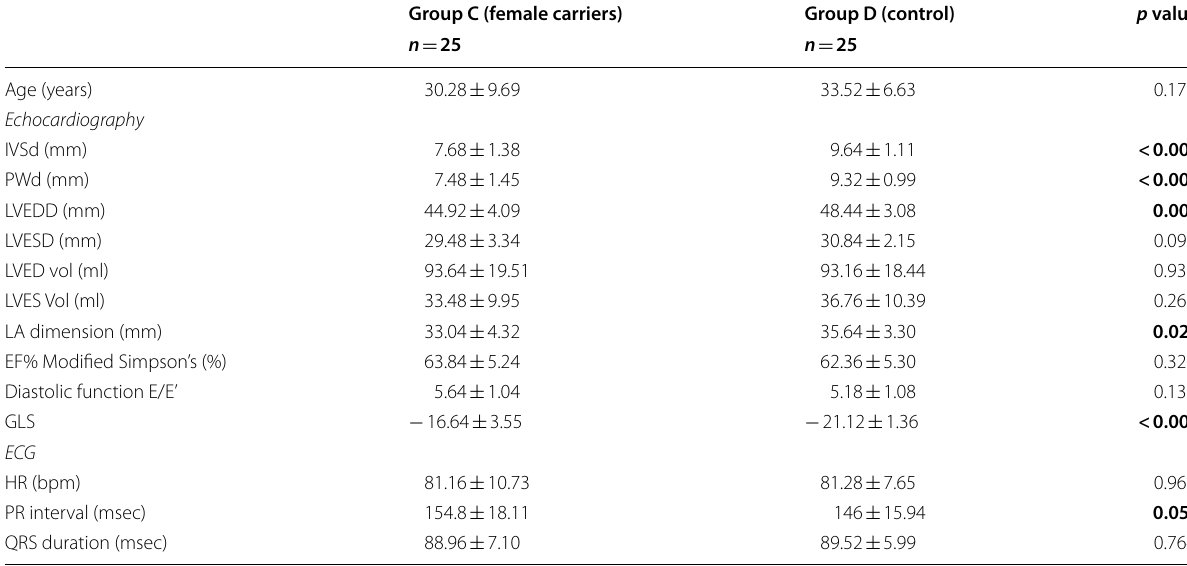
Table 2 Comparing ECG and echocardiographic findings between group C and group